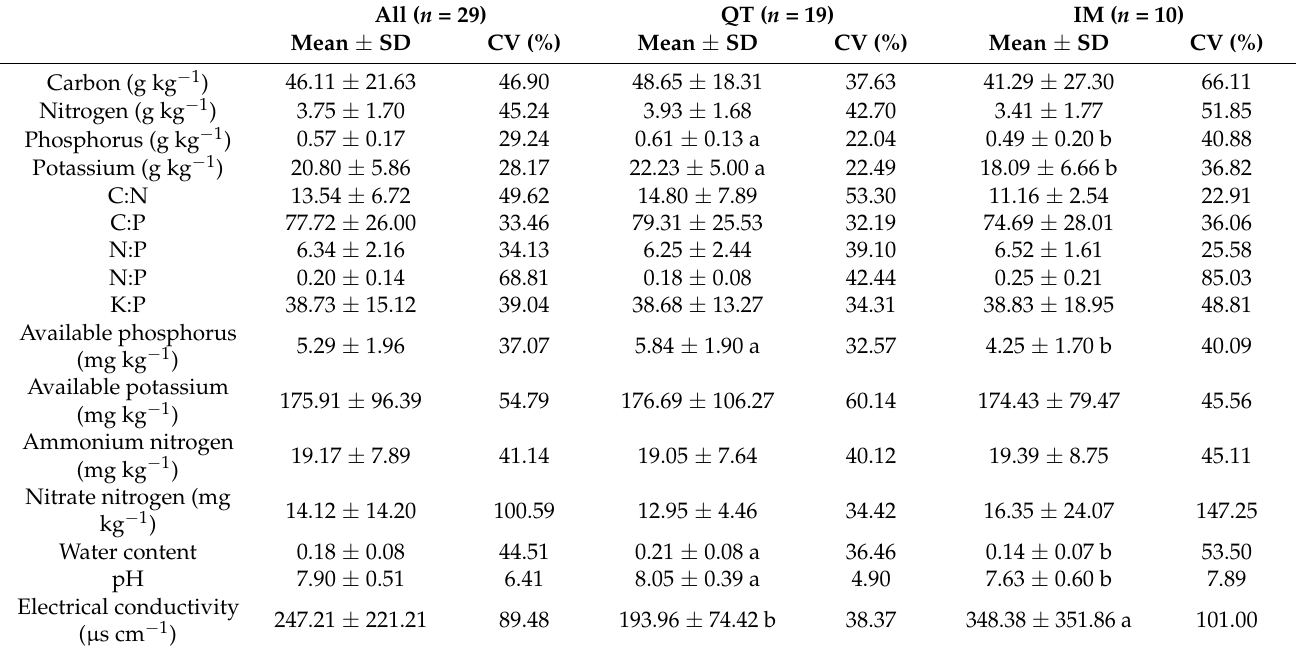
Table 2. Regional S. chamaejasme soil physicochemical properties. SD is the standard deviation and CV is the coefficient of variation. Differences between QT and IM were tested using independent t -test; significant differences at p < 0.05 are indicated by different letters.